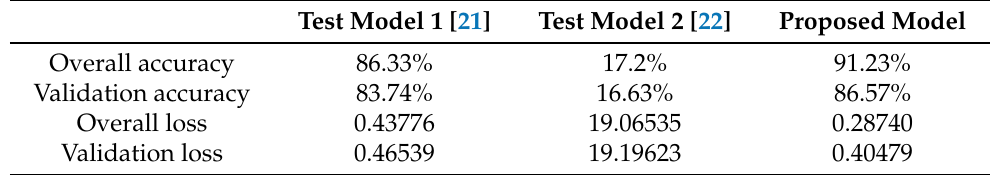
Table 6. First observation after 10 epochs of training.